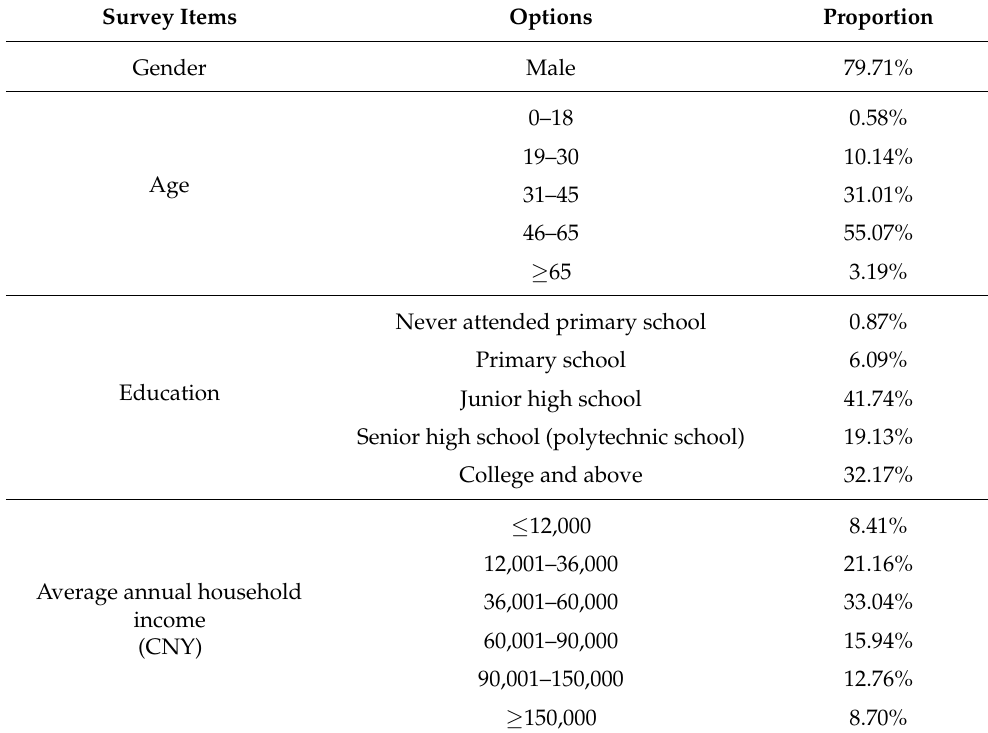
Table 4. Demographic data and characteristics of